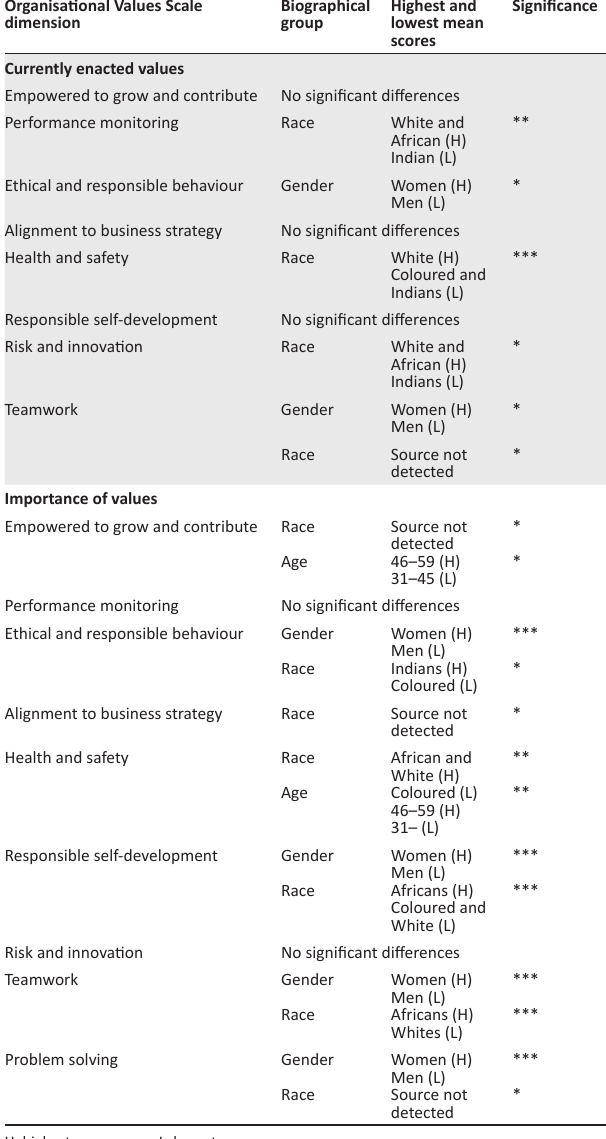
TABLE 7: Summary overview of the effect of significant differences in the biographical groups on the organisational value dimensions. Organisational Values Scale